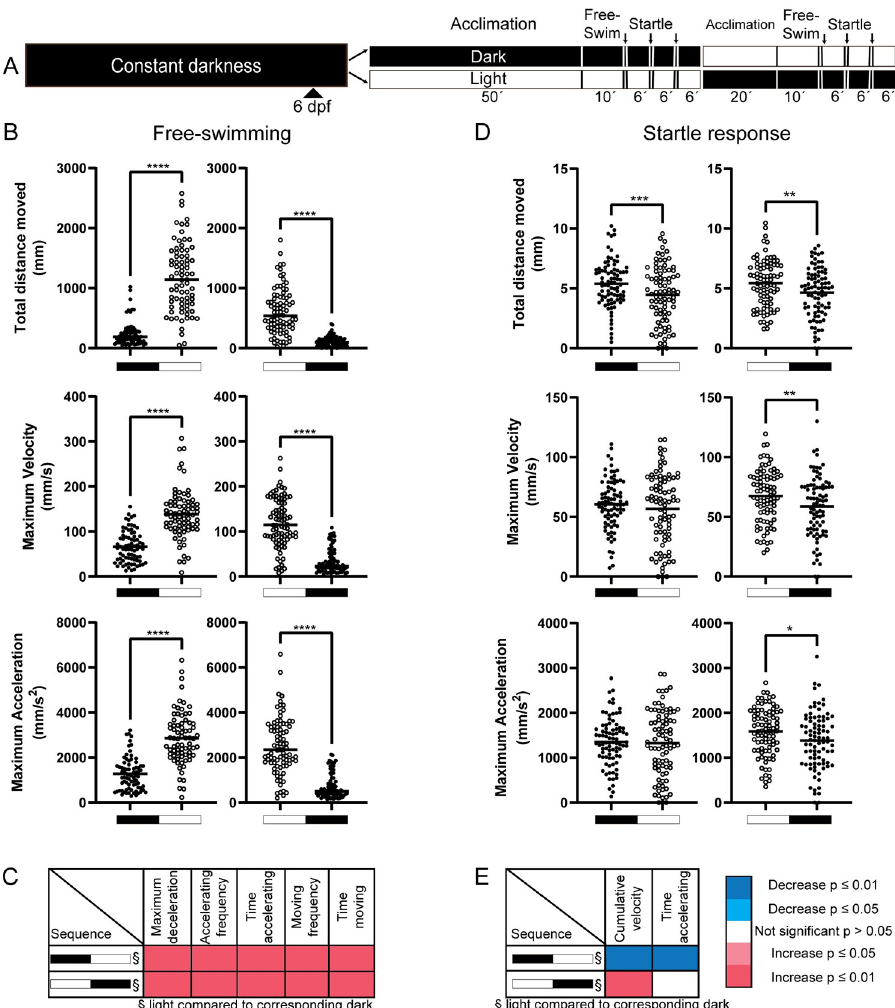
Fig 2. Regardless of order, under light condition same larvae had higher free-swim activity than under darkness. (A) Schematic of the experimental procedure. Embryos were kept under constant darkness (solid black bar) until the behavioral experiments. Each behavioral section had two components; free-swimming for 10 min under light (open circles; white) or dark (solid circles; black) conditions after a 50 min acclimation period under same illumination condition, and a set of startle responses (280 ms) where a sequence of three taps was executed with 6-minute interval; arrows designate timing of taps. For the sequential illumination test, larvae were given a 20-min acclimation period prior to assessing behavior under the illumination condition opposite to initial one. (B, C) Regardless of the order of illumination, larvae showed significantly more activity during free-swimming when tested under light conditions, compared to dark test conditions. (D, E) In terms of startle response behavior, almost all parameters decreased in second condition (regardless of illumination) representing potential habituation effect. Free-swimming: n = 76–86 per group, startle response: n = 85–87 per group. Data is presented in scatterplots showing individual values and group mean or median. Analysis was performed with paired t-tests. Significance: � p � 0.05, �� p � 0.01, ��� p � 0.001, ���� p �